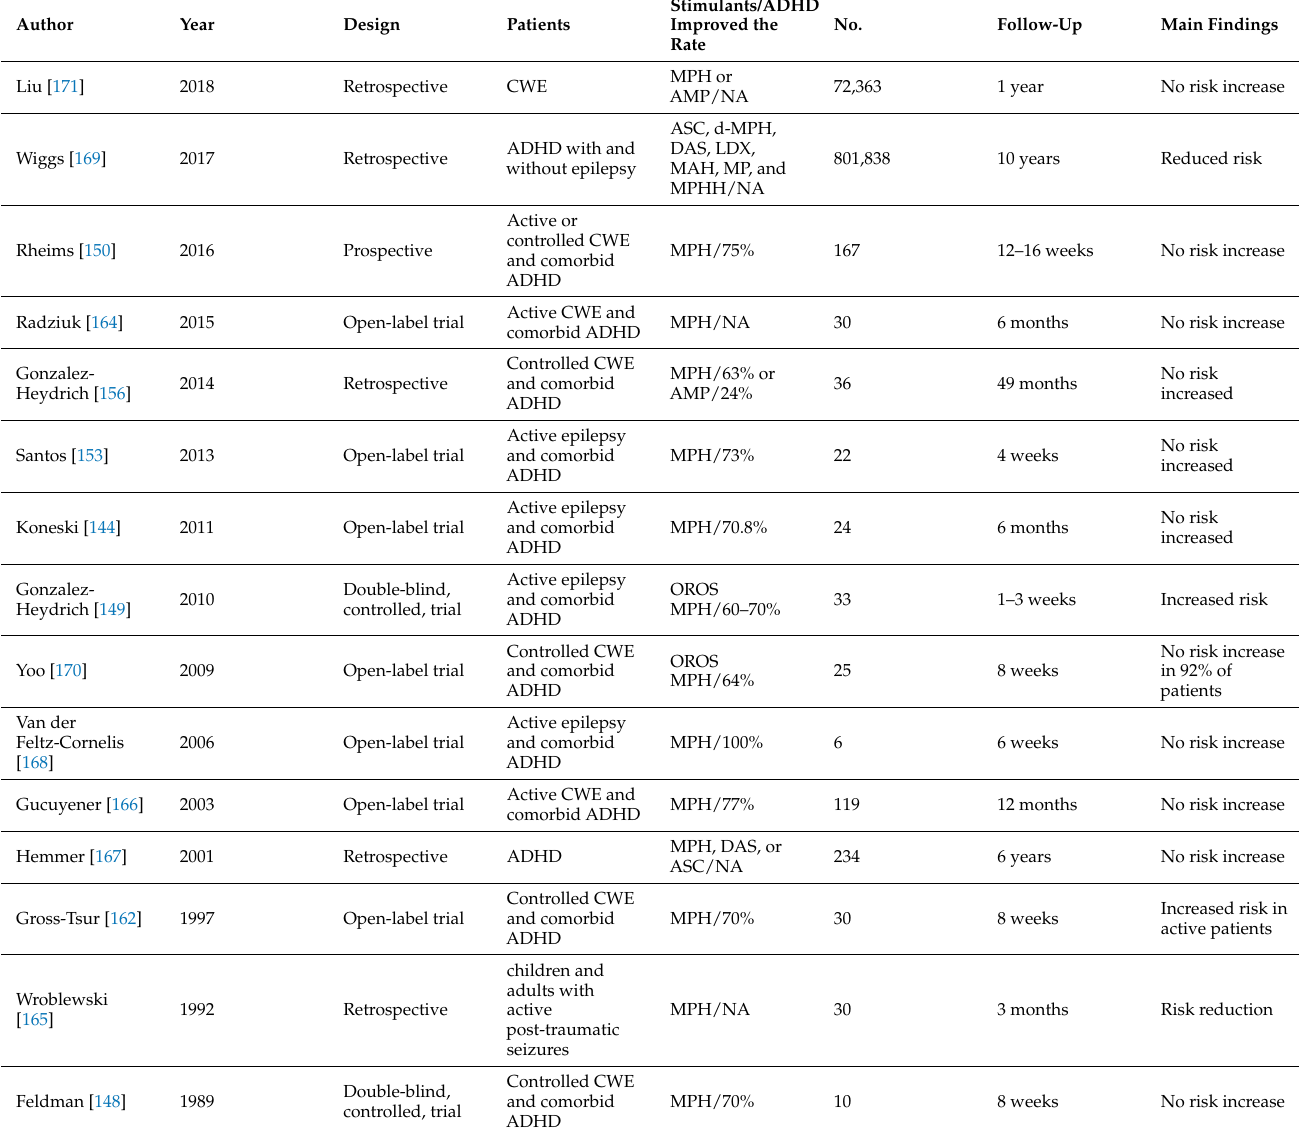
Table 3. Main Findings of Studies Reporting the Risk of Seizure in Patients on